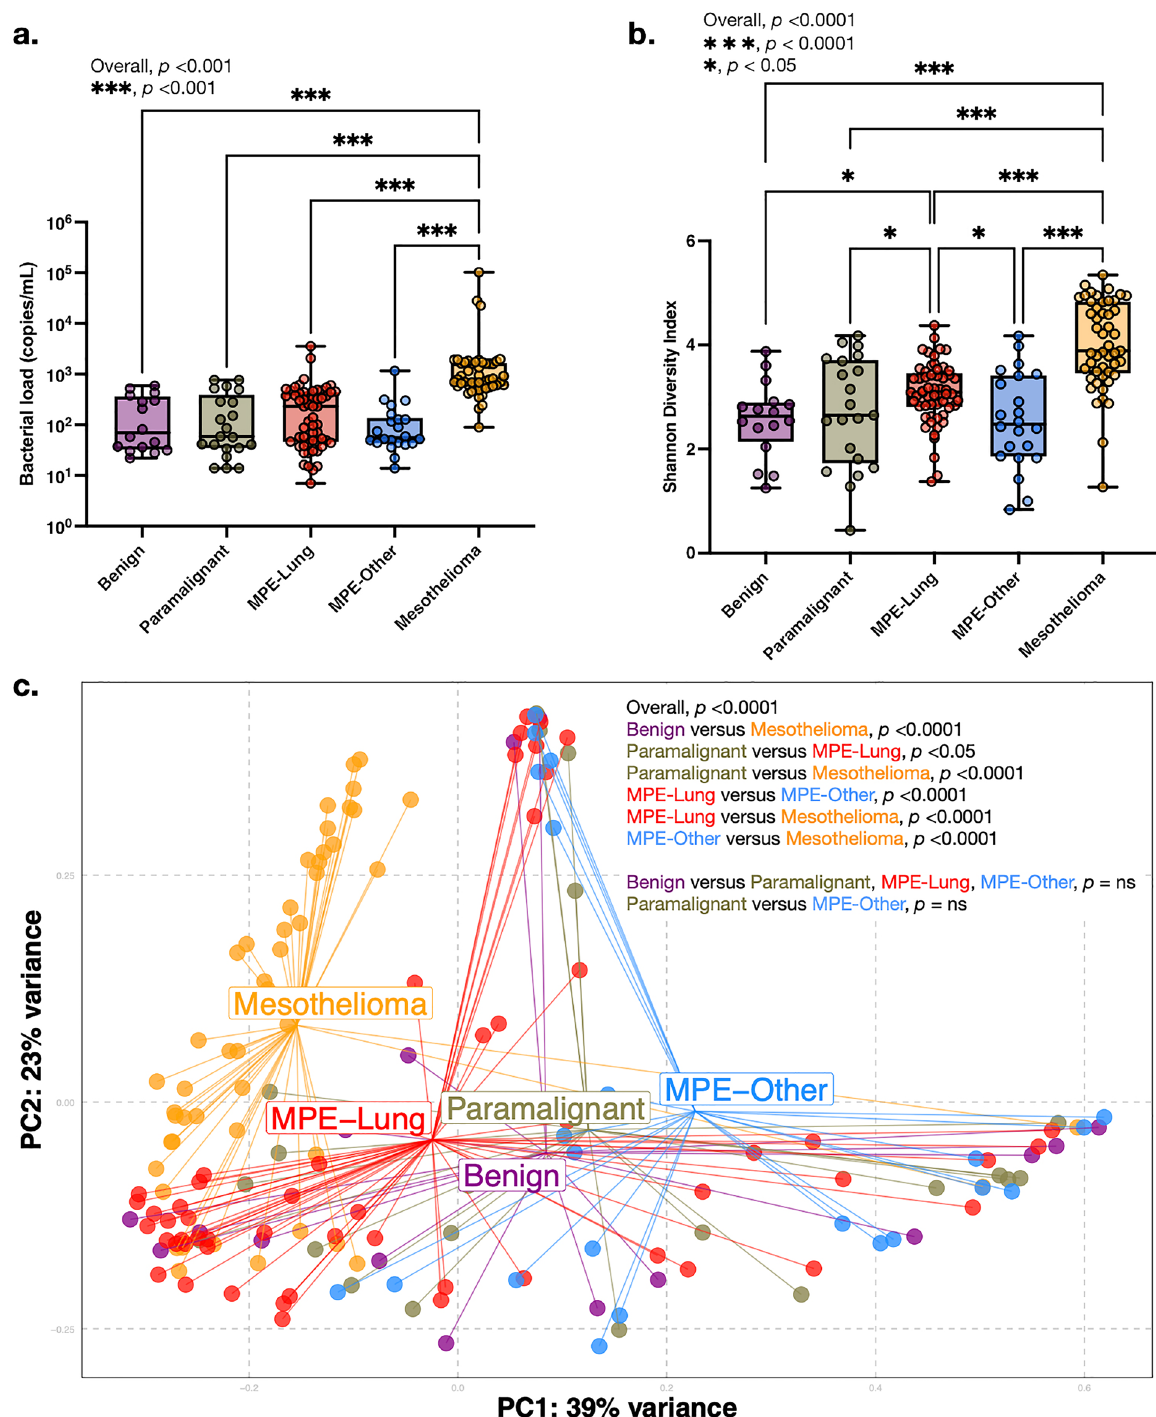
Figure 1. Microbial compositional differences between groups of pleural fluid. ( a ) Bacterial load (copies/ mL) by ddPCR. p -values by Kruskal–Wallis rank sum test; individual comparisons by Wilcoxon rank sum tests with Benjamini–Hochberg adjustment for multiple comparisons. ( b ) Alpha diversity (Shannon diversity). p -values by Kruskal–Wallis rank sum test. Individual comparisons by Wilcoxon rank sum tests with Benjamini– Hochberg adjustment for multiple comparisons. ( c ) Beta diversity (Bray–Curtis dissimilarity index). p -values by PERMANOVA. ns not